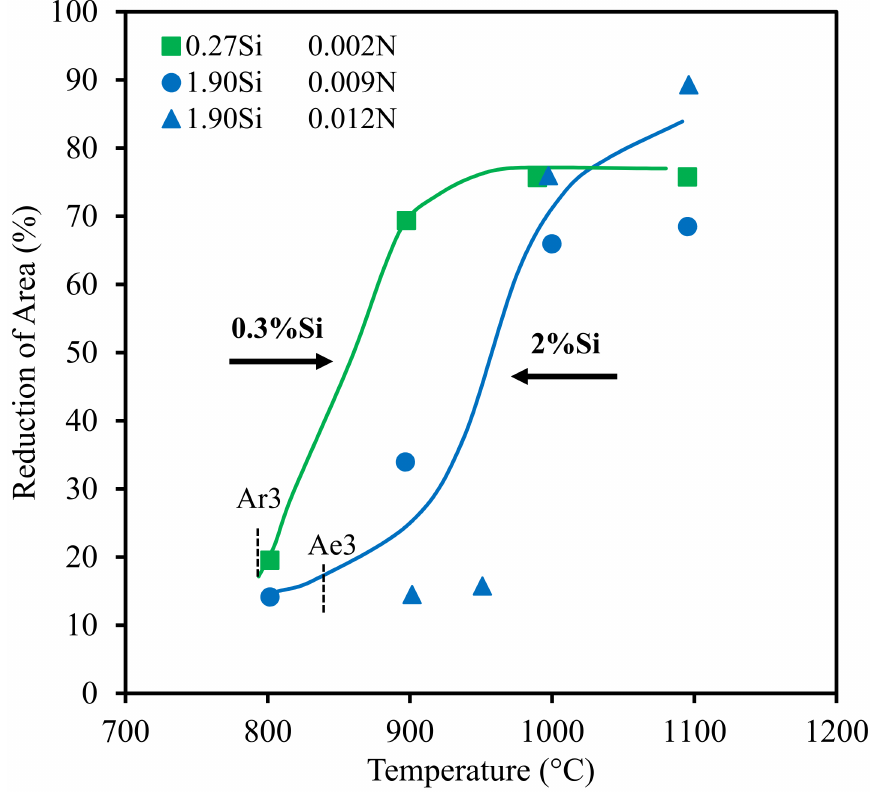
Figure 24. Influence of Si on the hot ductility of medium C steels (0.5% C, 0.01% N), again curve moves to higher temperature with increase in Si content